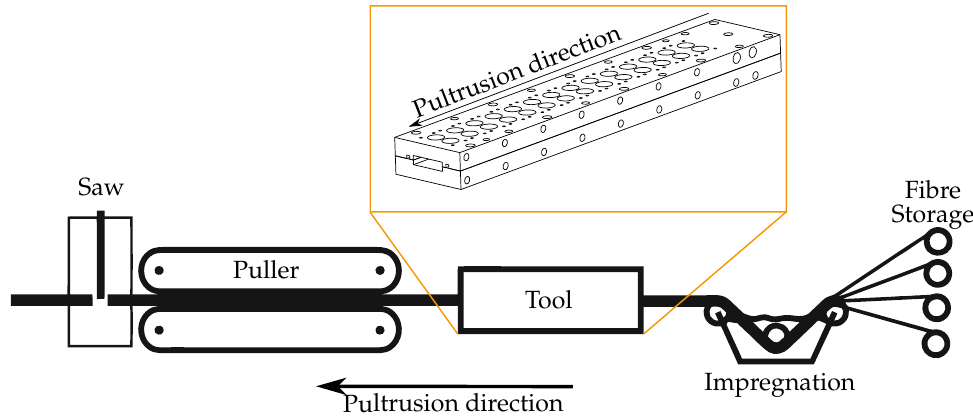
Figure 2. Schematic of a pultrusion line with an example